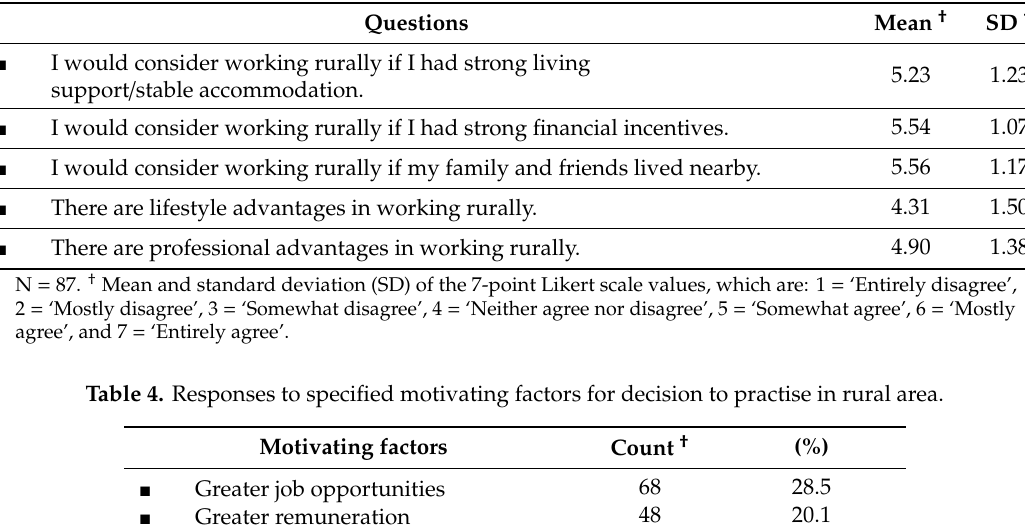
Table 3. First-year dental students’ perception of the influencing factors a ff ecting rural practice decision.